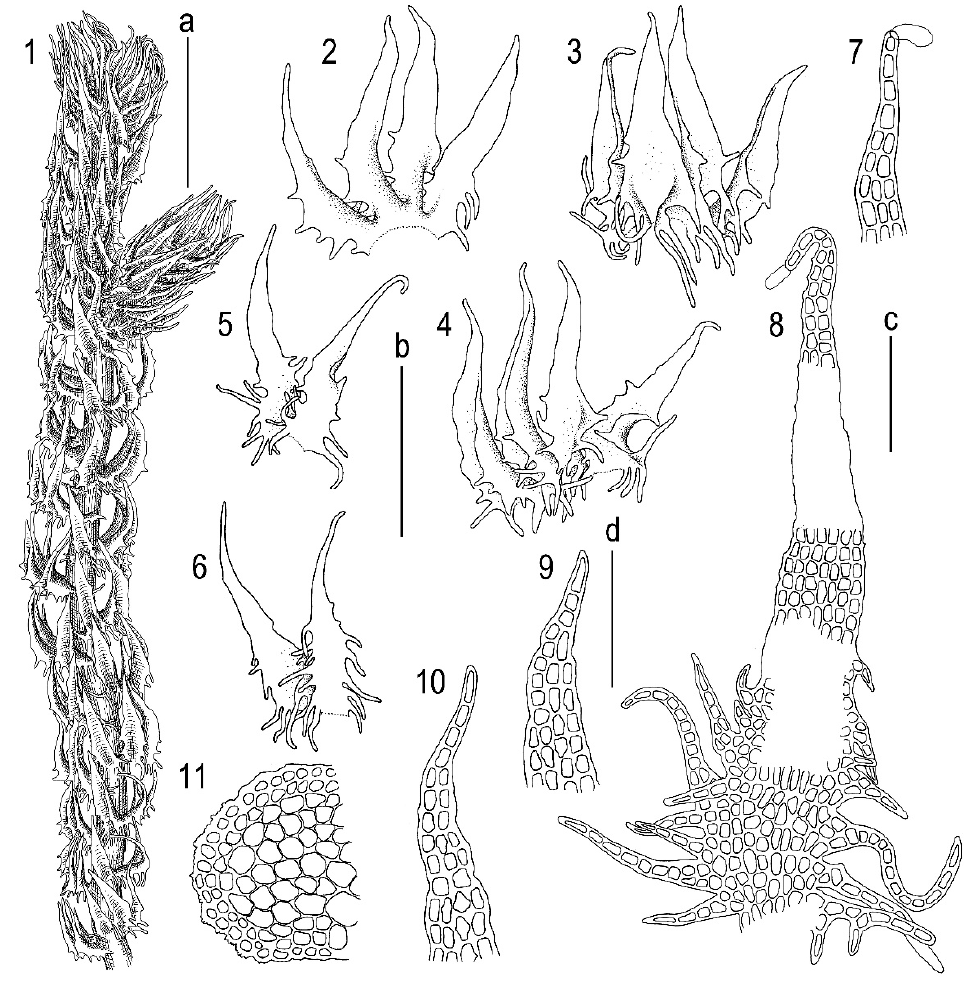
Figure 6. Tetralophozia filiformis (Steph.) Urmi: 1 —plant habit. ventral view; 2 – 4 —leaves; 5 , 6 — underleaves; 7 —underleaf lobe apex; 8 —leaf lobe; 9 , 10 —leaf lobe apex; 11 —stem cross section. fragment; Scales: a —1 mm. for 1; b —500 µm. for 2–6; c —100 µm. for 8; d —100 µm. for 7,9–11. All from China-40-16-17 (VBGI).